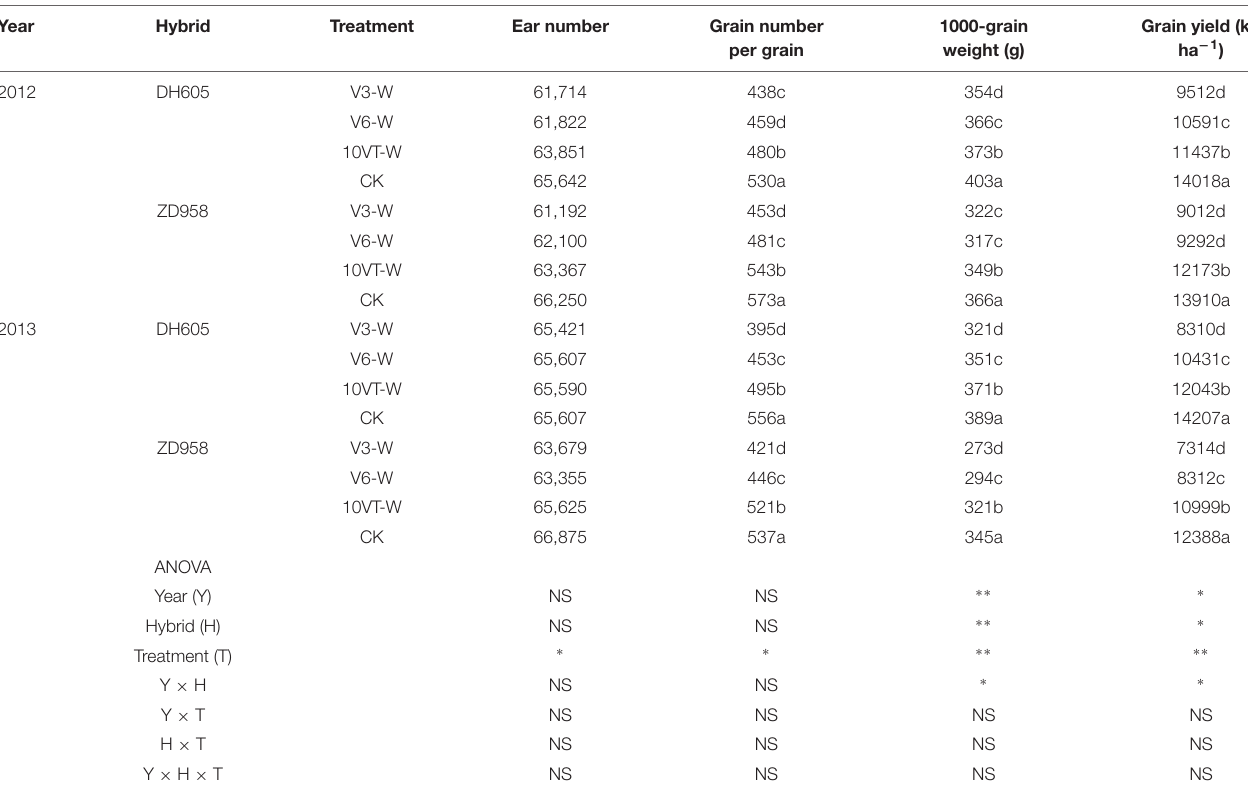
TABLE 4 | Effects of waterlogging on grain yield and yield components of